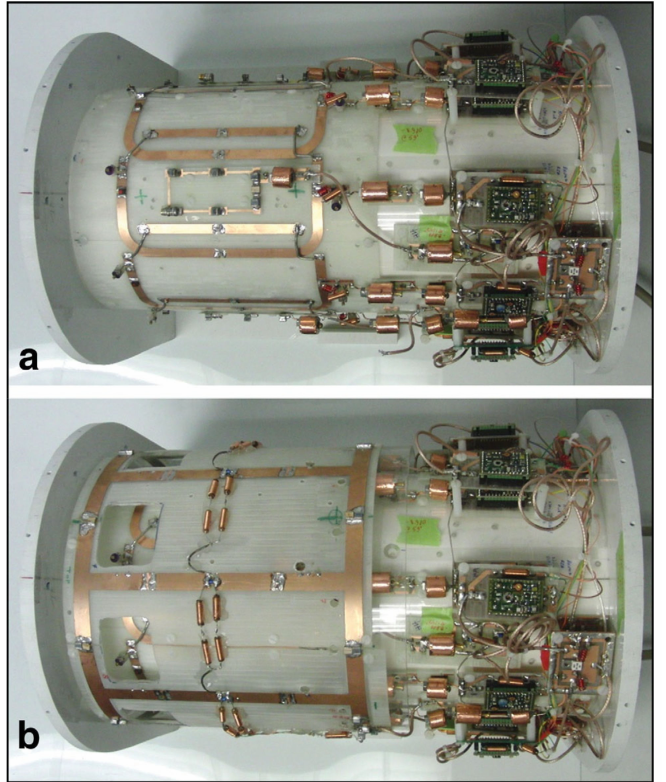
Figure 11. ( a )The eight-channel sodium receive array and four-channel transmit–receive hydrogen array on the inner former; ( b ) the detunable sodium birdcage on the outer former. Reprinted by permission from Brown et al., Magn Reson Med 2013